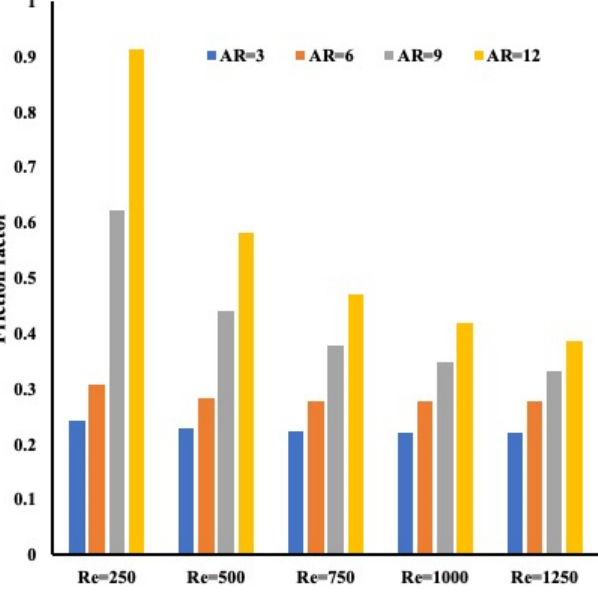
Figure 9. Friction factor for all cases.